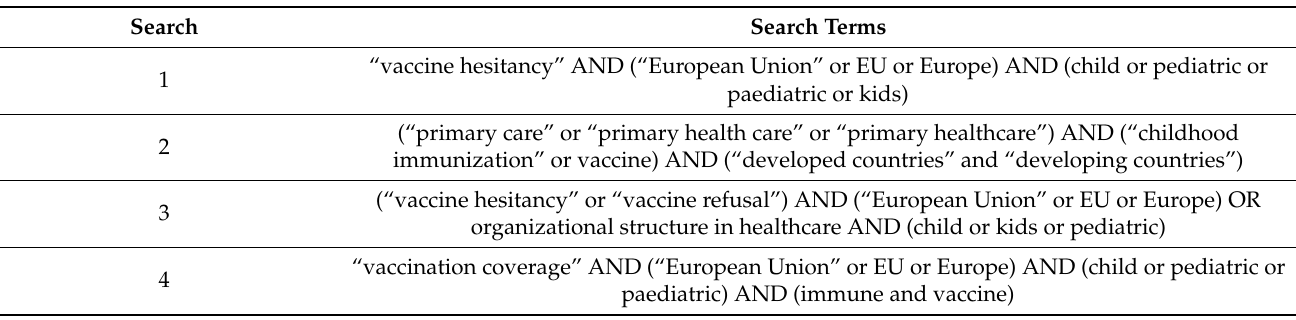
Table 1. Search-related keywords and Boolean operators.